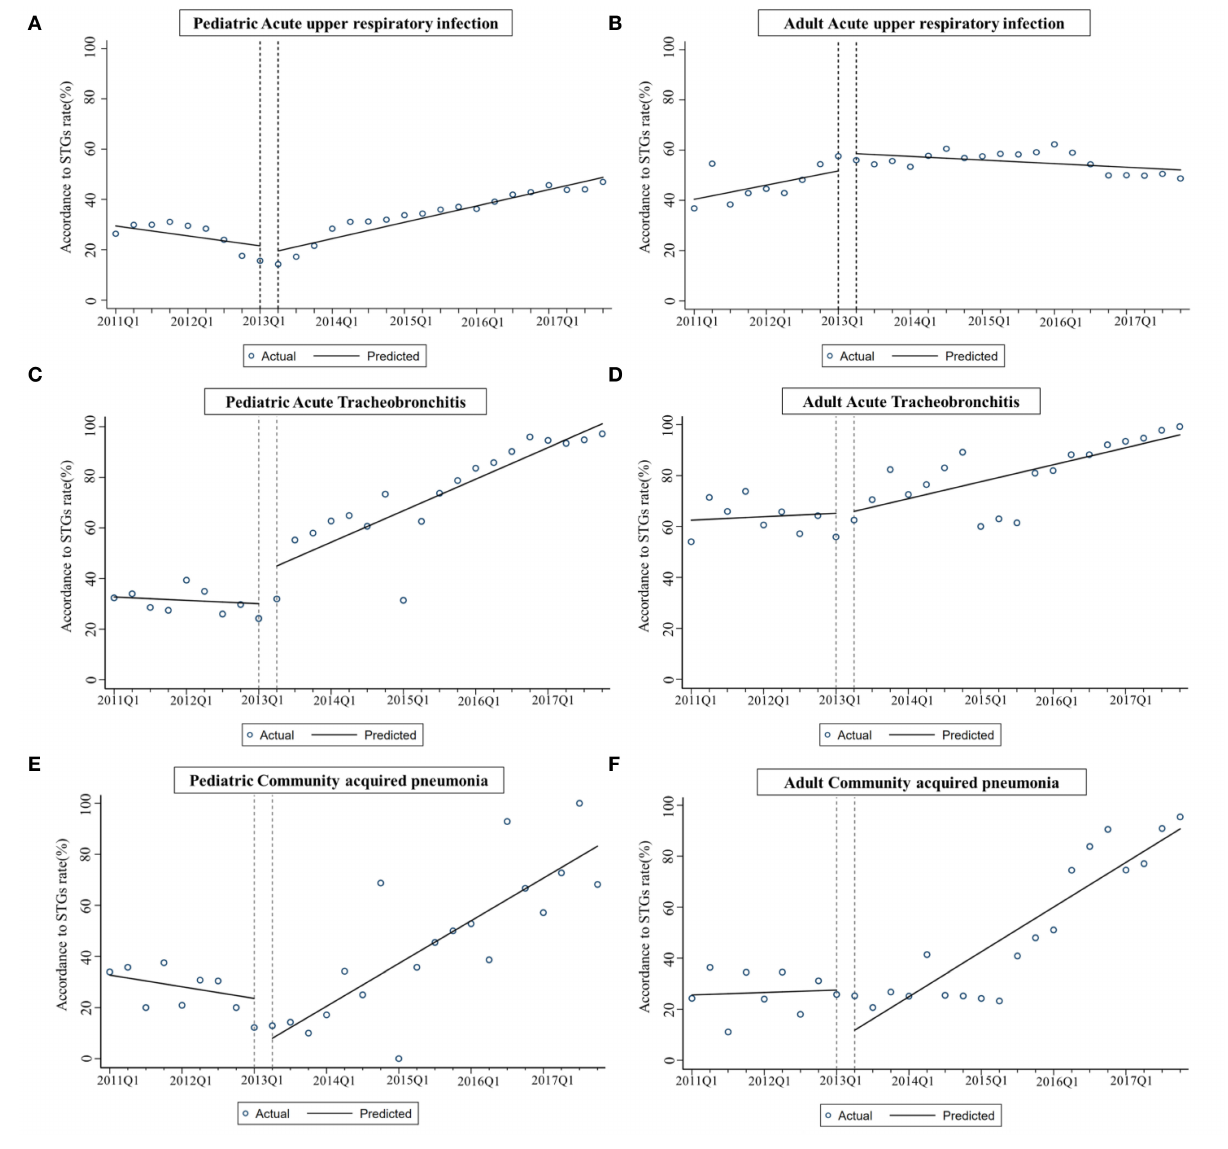
FIGURE 1 | (A–F) Estimates from interrupted time-series models of changes in STGs compliance rate for children and adult with three sample diseases after the